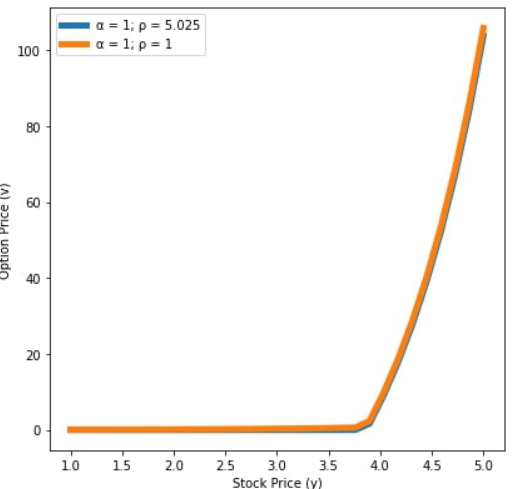
Figure 8. Values of the options for α = 1 and ρ > 1, t = 0.5 years with x =